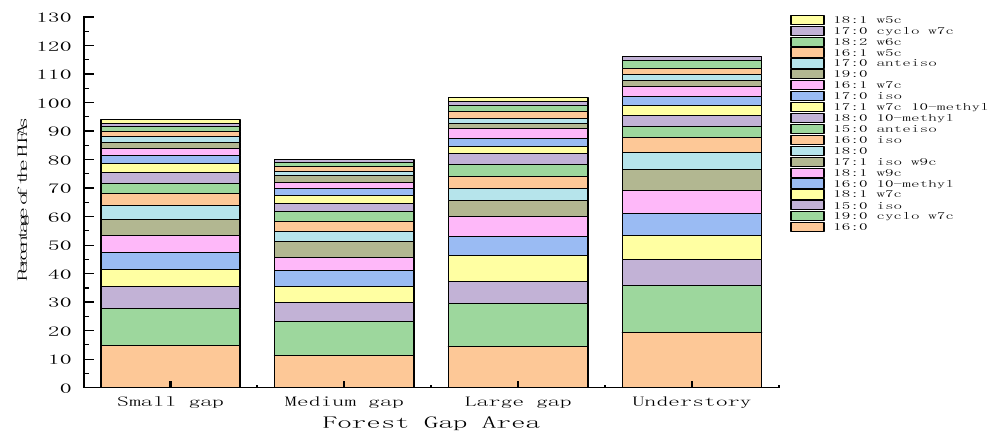
Figure 3. The percentage of PLFAS charactering microbes in forest gaps of different sizes. Compared to Table 3. Total amount of soil microbial PLFAs under the forest gap area (mean ± SE, 95% CI).